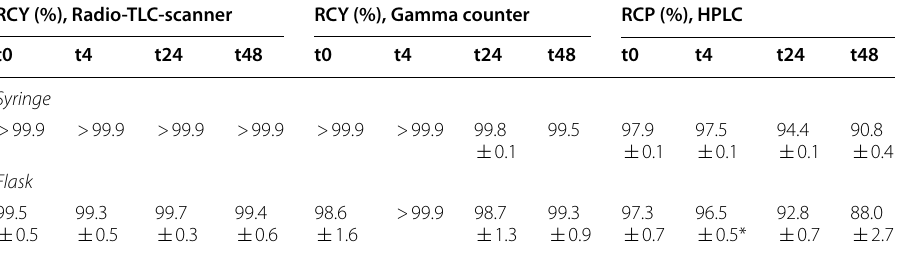
0, 4, 24 and 48 h) =